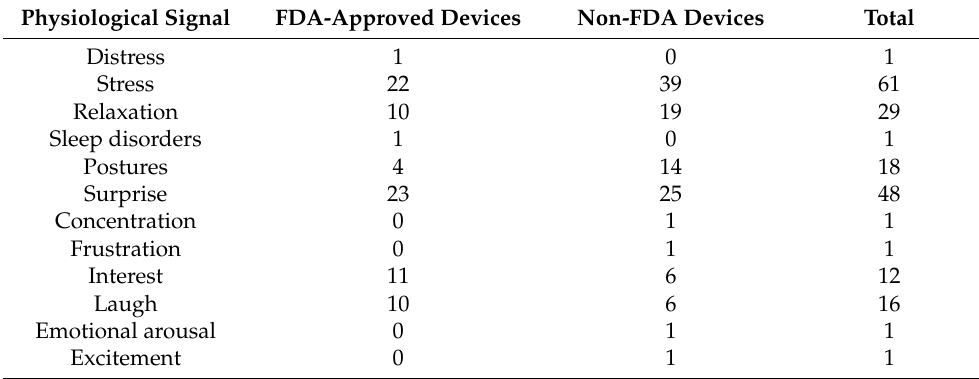
Table 3. Main Physiological Signals for Engagement Detection.